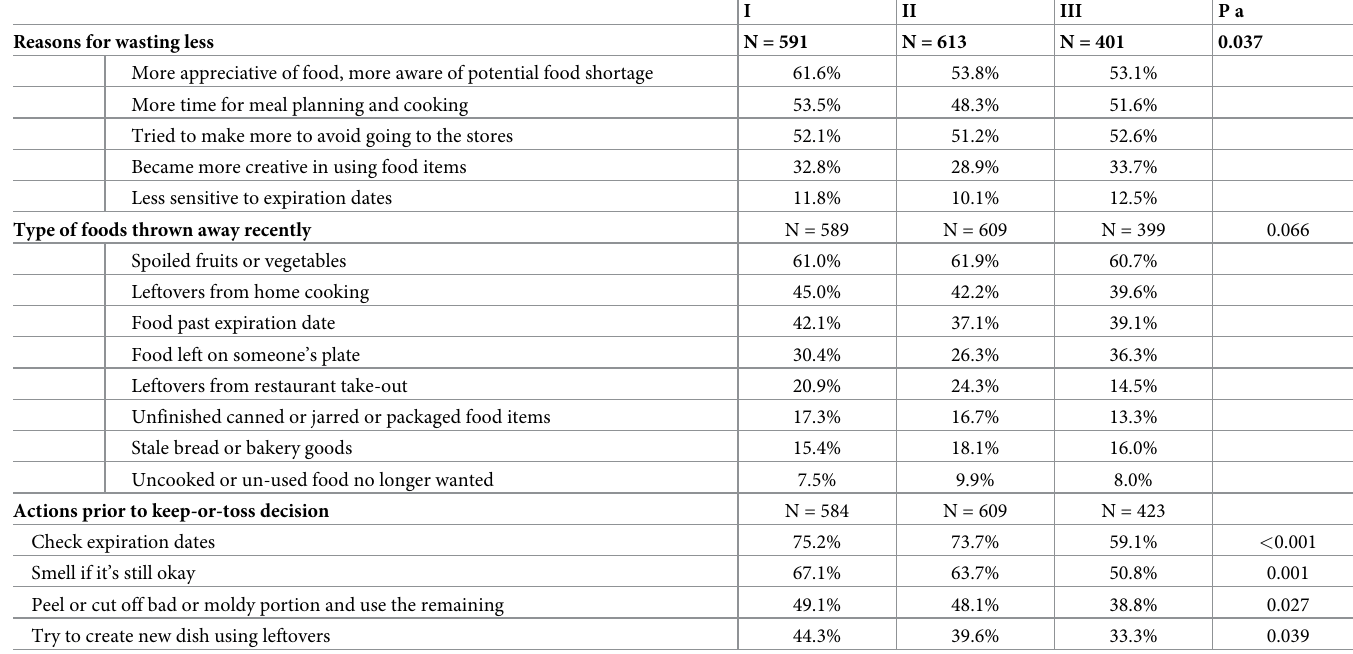
Table 3. Reasons, categories and behaviors for discarding food during COVID-19 quarantine, as reported by different age groups.